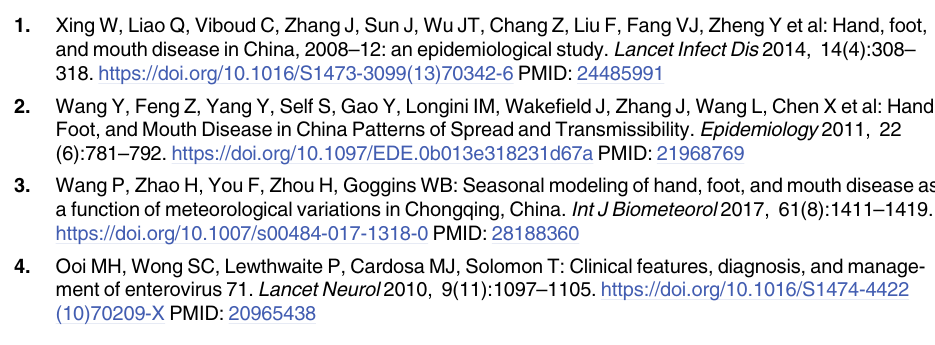
S1 Fig. Local wavelet power spectrum for HFMD cases in each county of Qinghai. S2 Fig. Local wavelet power spectrums for HFMD cases in each county of Shanghai. S3 Fig. Posterior predictive distribution for HFMD cases in Qinghai. S4 Fig. Posterior predictive distribution for HFMD cases in Shanghai. S5 Fig. Empirical adjust reproductive number for incidence series of HFMD cases in Qing- hai. S6 Fig. Empirical adjust reproductive number for incidence series of HFMD cases in Shanghai. S1 Table. Bayes factors of model comparison for HFMD cases in Qinghai. S2 Table. Bayes factors of model comparison for HFMD cases in Shanghai. S3 Table. Posterior estimates (mean, 95% credible interval, and median) of the parameters in the dispersion